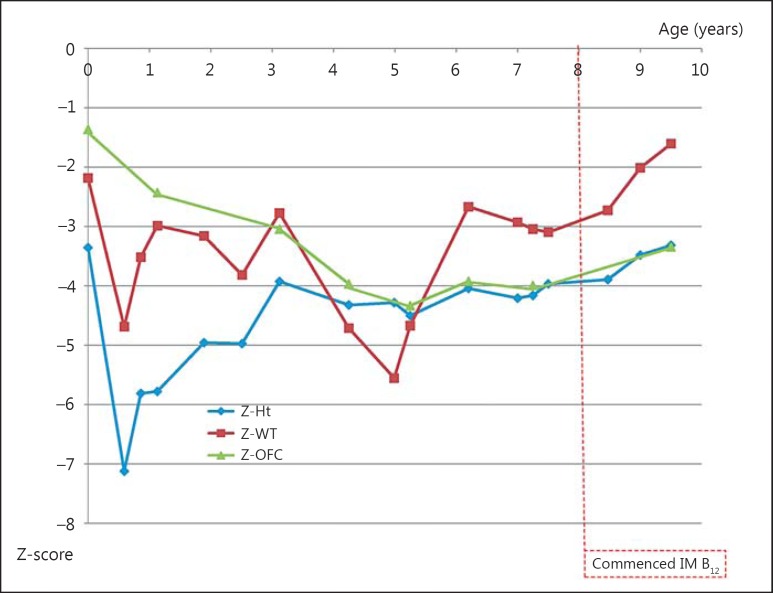
Growth parameters in the proband before and after institution of intramuscular (IM) hydroxocobalamin.